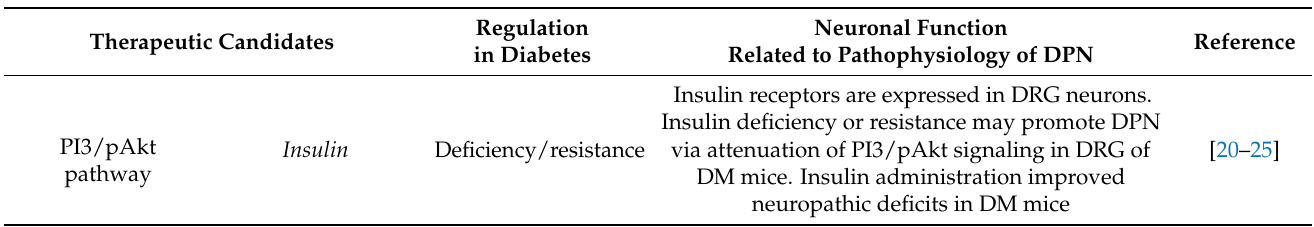
Table 1. A selective list of therapeutic molecular candidates in DRG sensory neurons for DPN in this